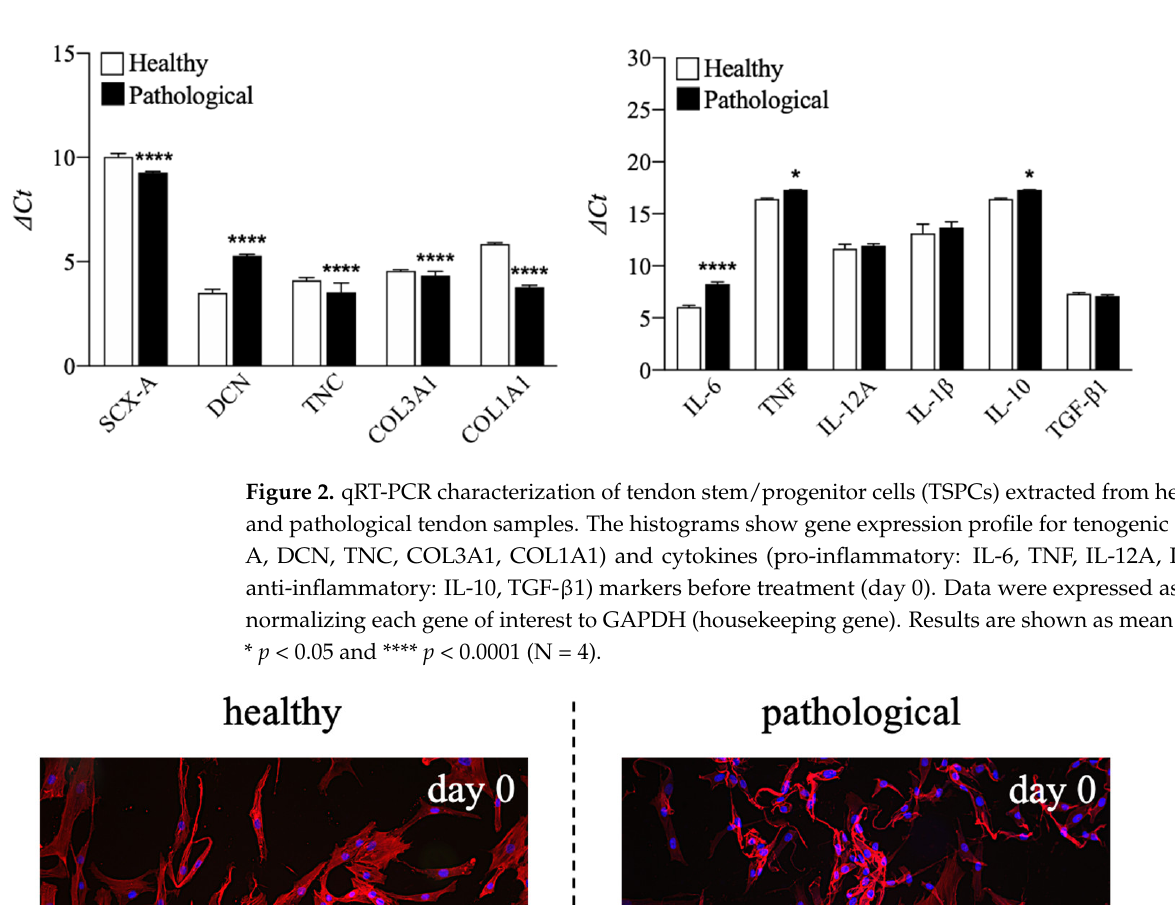
Figure 2. qRT-PCR characterization of tendon stem/progenitor cells (TSPCs) extracted from healthy and pathological tendon samples. The histograms show gene expression profile for tenogenic (SCX-A, DCN, TNC, COL3A1, COL1A1) and cytokines (pro-inflammatory: IL-6, TNF, IL-12A, IL-1β; anti-inflammatory: IL-10, TGF-β1) markers before treatment (day 0). Data were expressed as ΔCt, normalizing each gene of interest to GAPDH (housekeeping gene). Results are shown as mean±SD. * p < 0.05 and **** p < 0.0001 (N = 4).